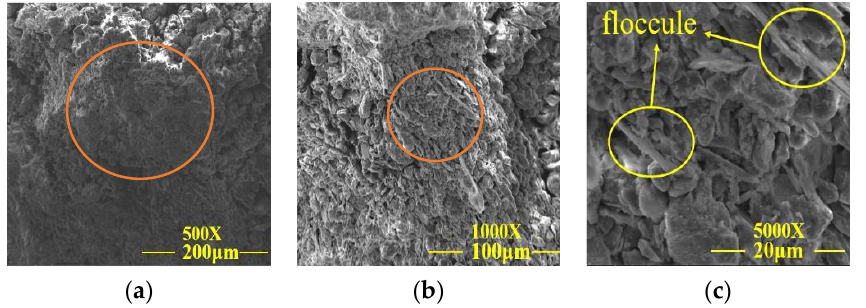
Figure 11. SEM images of the test group 24. ( a ) SEM analysis at a magnification of 500×; ( b ) SEM